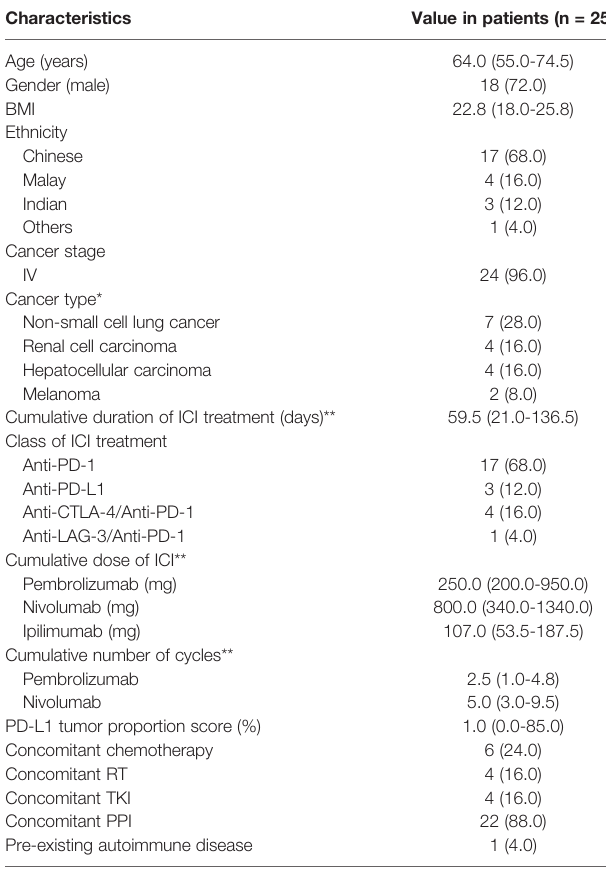
TABLE 1 | Clinical characteristics in patients with ICI-induced